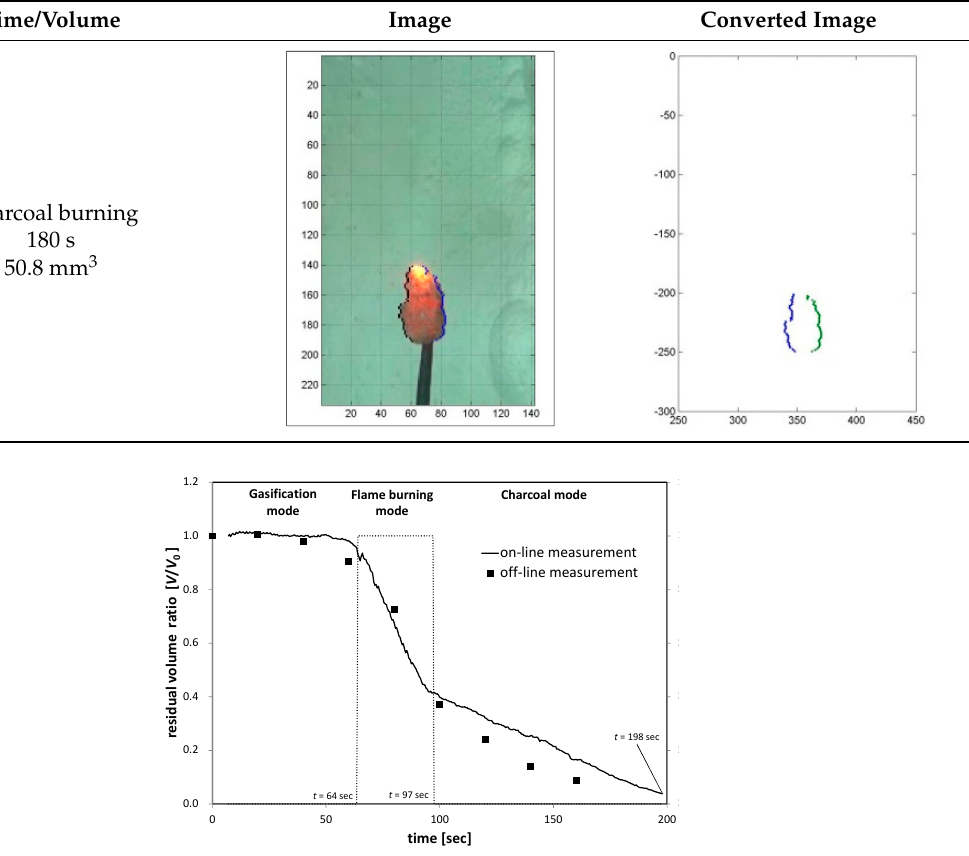
Figure 10. Comparison of volume measurement between off-line and on-line measurement. At the beginning of the gasification mode, there is a volume increase caused by evaporation of water and pyrolysis inside the wood pellet (Figure 10). In the gasification mode, the volume change is very low. However, in the flame burning mode, an abrupt volume change occurs due to high energy emission by flame burning. The charcoal burning mode takes a long time: up to 51.6% of the total burn time. With this volume measurement method, we can easily and continuously measure volume change of the burning wood pellet, without any disturbance of combustion condition, from gasification mode to the end of combustion. At the end of combustion, the wood pellet’s volume was 5% of the original pellet. We compare standardized char conversion time (char conversion time divided by density of the wood pellet) to a previous study by Biswas et al. [18]. Char conversion time is defined as the period starting at the moment when the flame around the pellet disappeared until the moment that the glowing of the char stopped [18]. Biswas et al. concluded that standardized char conversion times of the wood pellet with apparent density up to 1200 kg/m 3 remain constant about 80–100 cm 3 ·s/g. In the present study, standardized char conversion time is 82.3 cm 3 ·s/g, as shown in Figure 11. During off-line measurement, we measure volume and mass of the wood pellet at each sampling. From the measurement, we can find the density of the wood pellet at each sampling, i.e., density is mass divided by volume. Figure 12 shows wood pellet density measurement results and data fitting for calculation of the wood pellet. From the beginning of gasification mode to the end of flame burning mode, the density of wood pellet decreases as a quadratic function. On the contrary, density of the wood pellet at charcoal mode is almost constant and density average value is 307.5 kg/m 3 . So we assume density as a quadratic function that passes through ρ wood pellet (1213 kg/m 3 ) at t = 0 s and ρ charcoal (307.5 kg/m 3 ) at the end of flame burning mode ( t = 94 s) as the following equation: